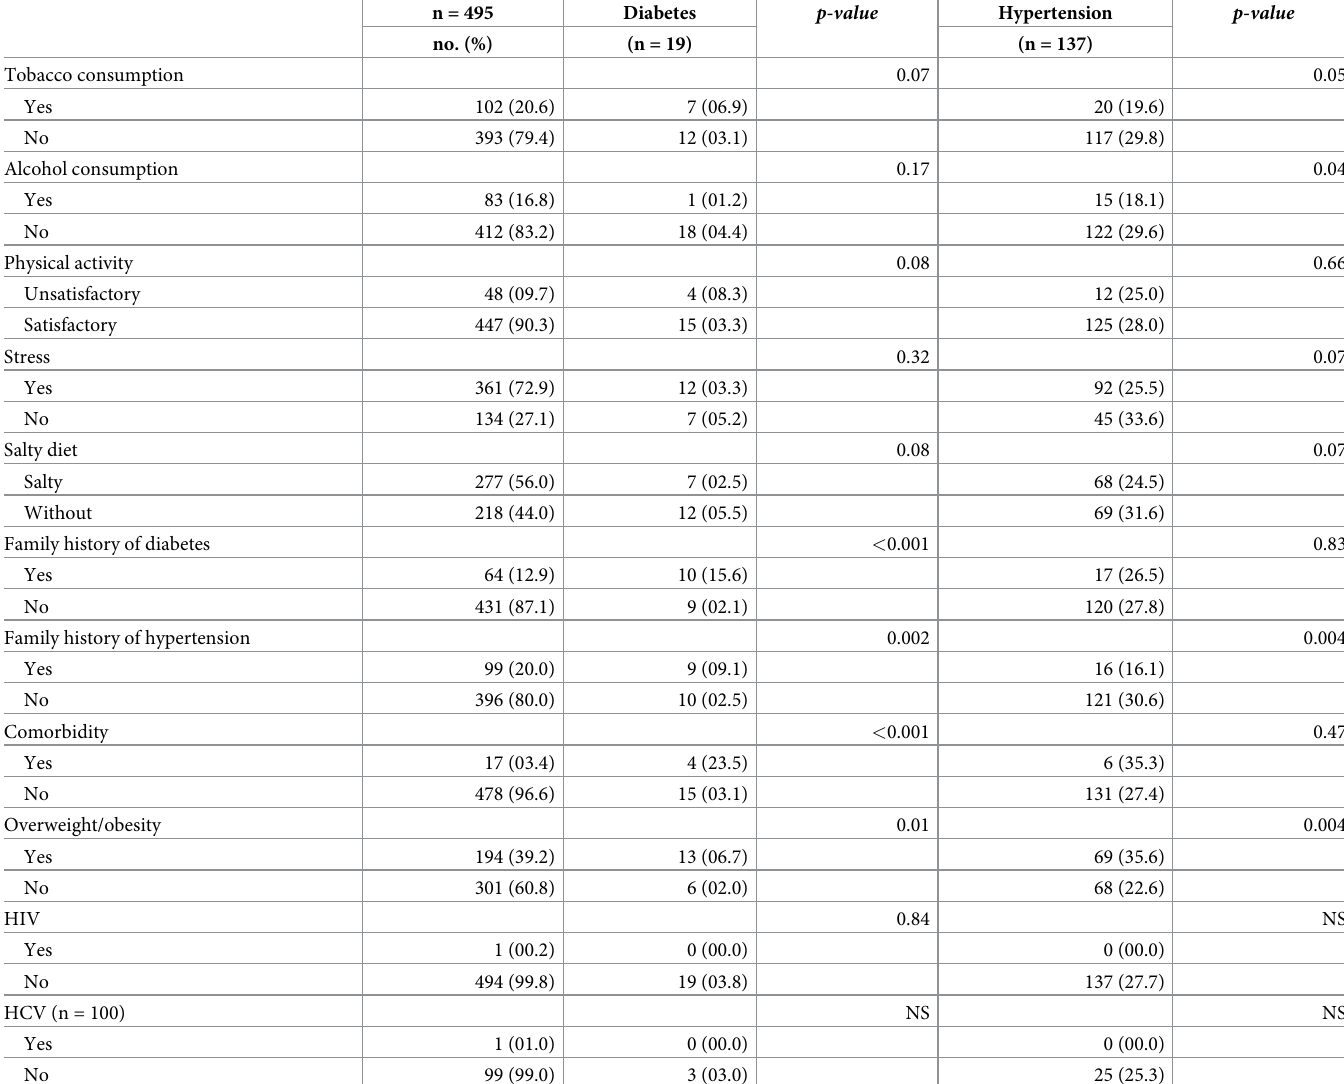
Table 2. Behavioral and clinical characteristics of the migrant population, Oujda, Morocco, 2021. n =